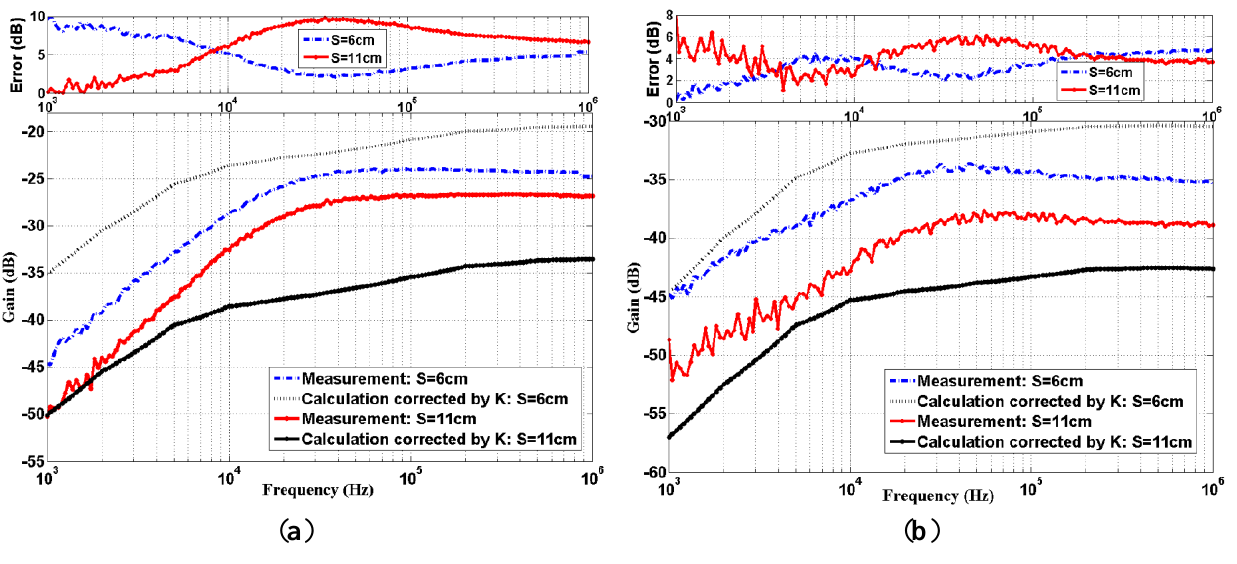
Figure 4. Measured and calculated (with correction) transfer function characteristic